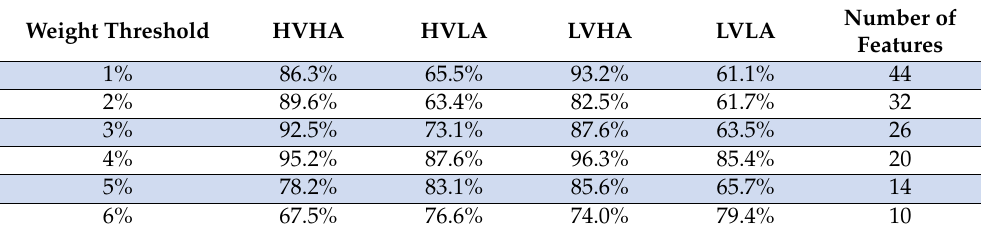
Table 5. Results of emotion recognition.